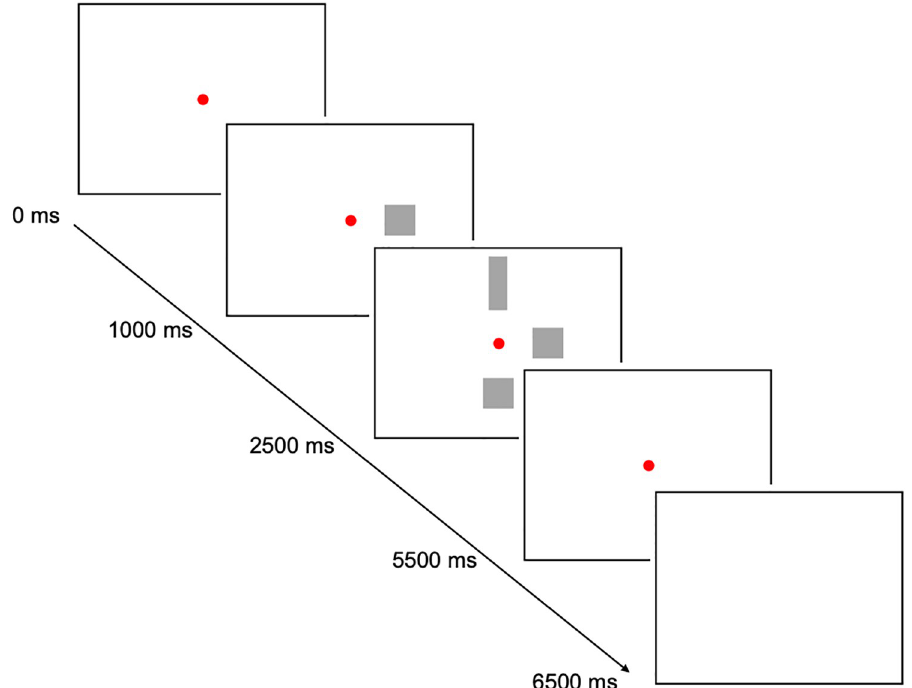
Fig 2. Schematic overview of the task-paradigm for the assessment of shape-perception with the cumulative time in ms.